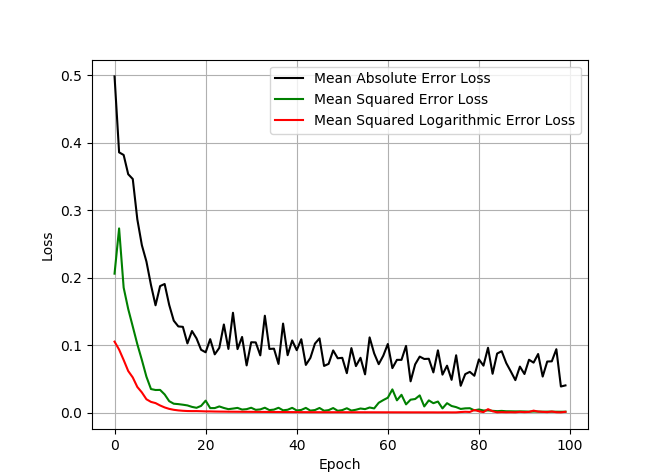
Figure 12. Performance of different loss